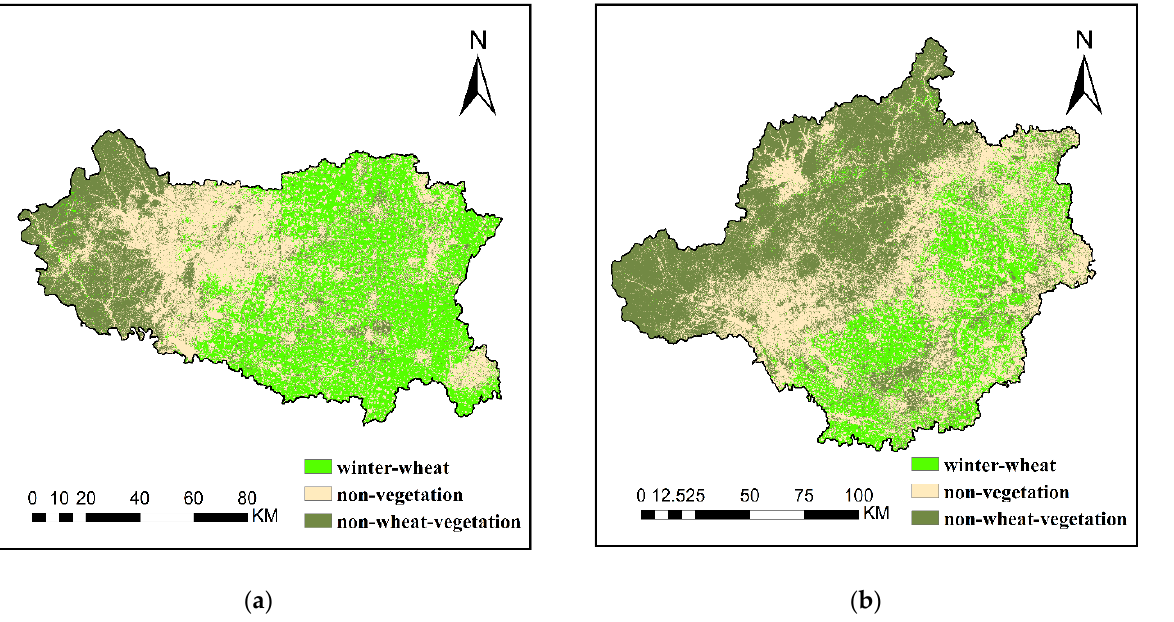
Figure 9. ( a ) Distribution of winter wheat in Handan in 2018. ( b ) Distribution of winter wheat in Baoding in 2018.